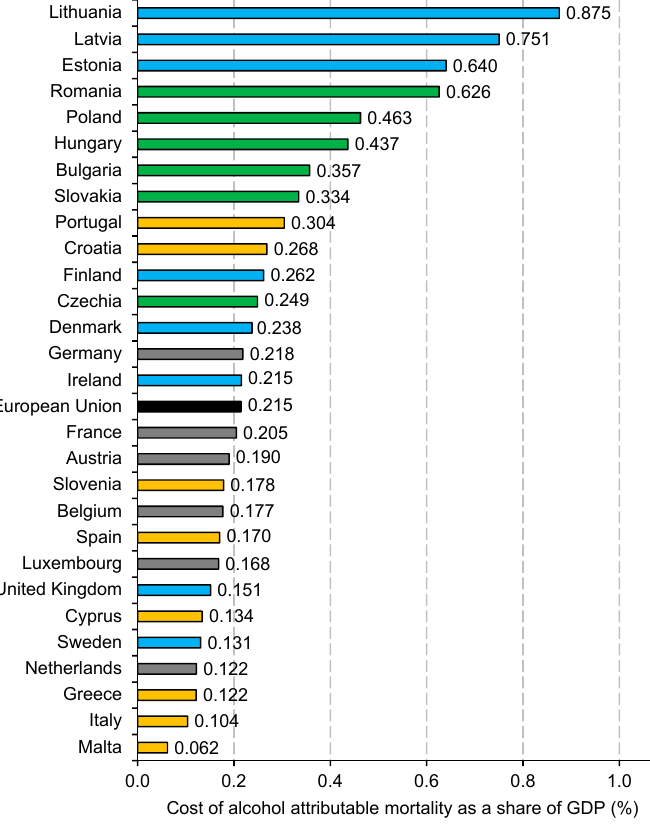
Figure 1. Production losses associated with alcohol-attributable mortality as a share of gross domestic product in 28 European Union countries, 2016. Notes: The bar colors mark a geographic group of countries as follows (the values in brackets show sub-regional averages): green—Central and Eastern Europe (0.444% of GDP); blue—Northern Europe (0.192% of GDP); orange—Southern Europe (0.146% of GDP); grey—Western Europe (0.200% of GDP); black—the average European Union value.